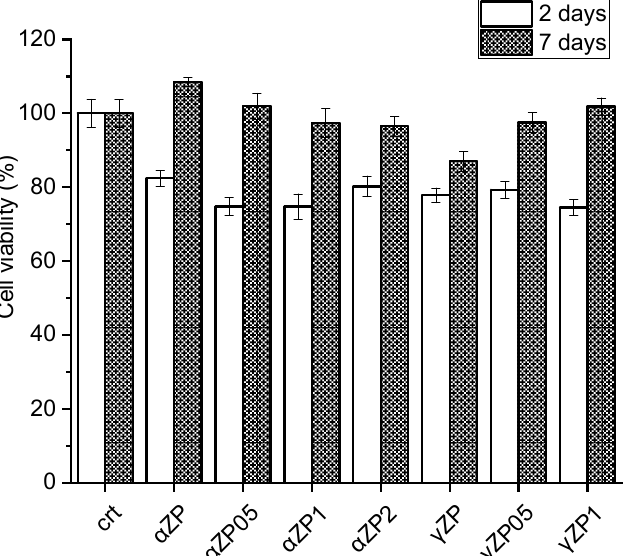
Figure 11. Cytotoxicity of α ZP and γ ZP to human bone osteosarcoma (MG63) cells after 2 days and 7 days of incubation.